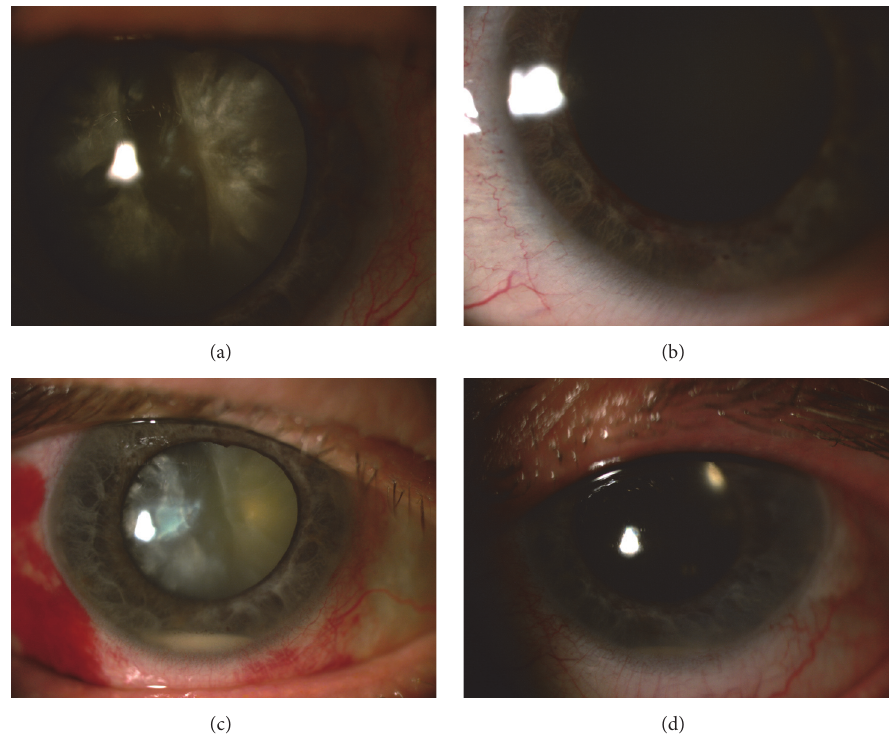
Figure 1: Color anterior segment picture: (a) right eye, whitish cataract and rubeosis iridis at the presentation; (b) left eye, nuclear sclerosis and rubeosis iridis at the presentation; (c) right eye, hypopyon, regressed rubeotic vessels, and the whitish cataract at the third postinjection day; (d) left eye, mild corneal edema, hypopyon, and intraocular lens at the second postcataract surgery (seventh postinjection day). (Figures 1(a) and 1(b)). Intraocular pressure was 16 mm